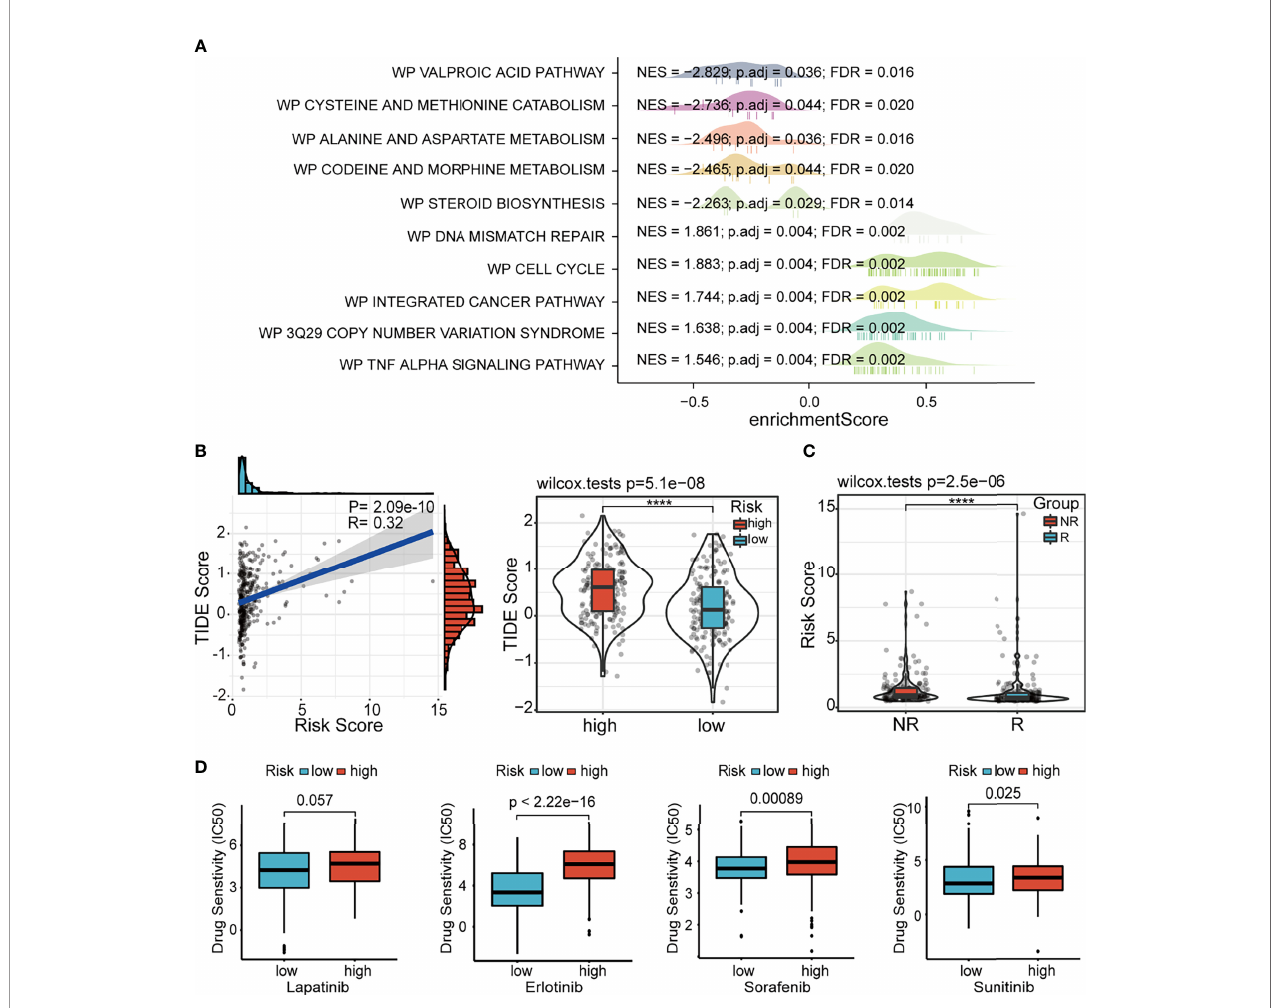
FIGURE 9 | GSEA and drug susceptibility analysis. (A) GSEA of ferroptosis-associated lncRNA signature based on WikiPathways database. (B) Correlation between the risk score and the TIDE score. (C) Correlation between the risk score and immune checkpoint blockade response. GSEA, gene set enrichment analysis; lncRNA, long non-coding